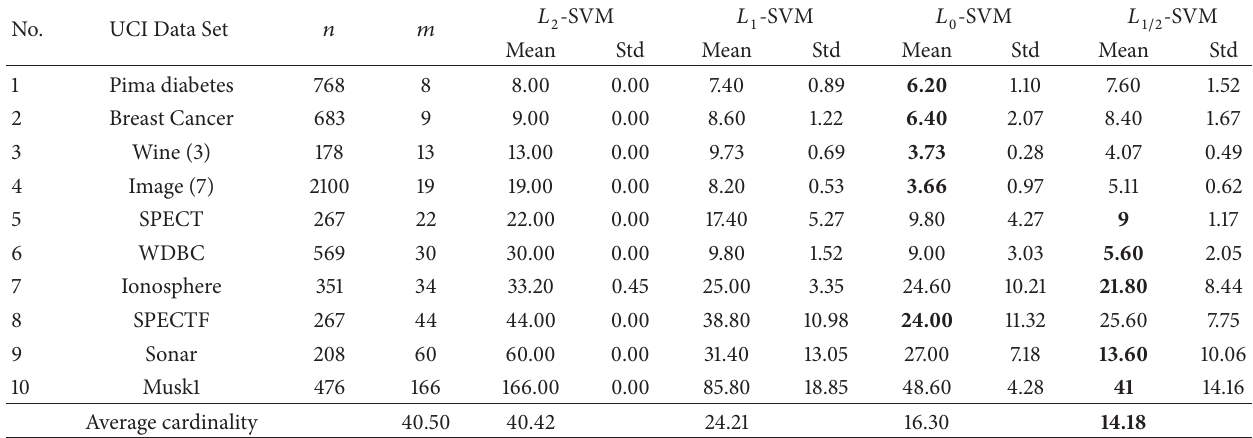
Table 4: Feature selection performance comparison on UCI data sets (Cardinality).